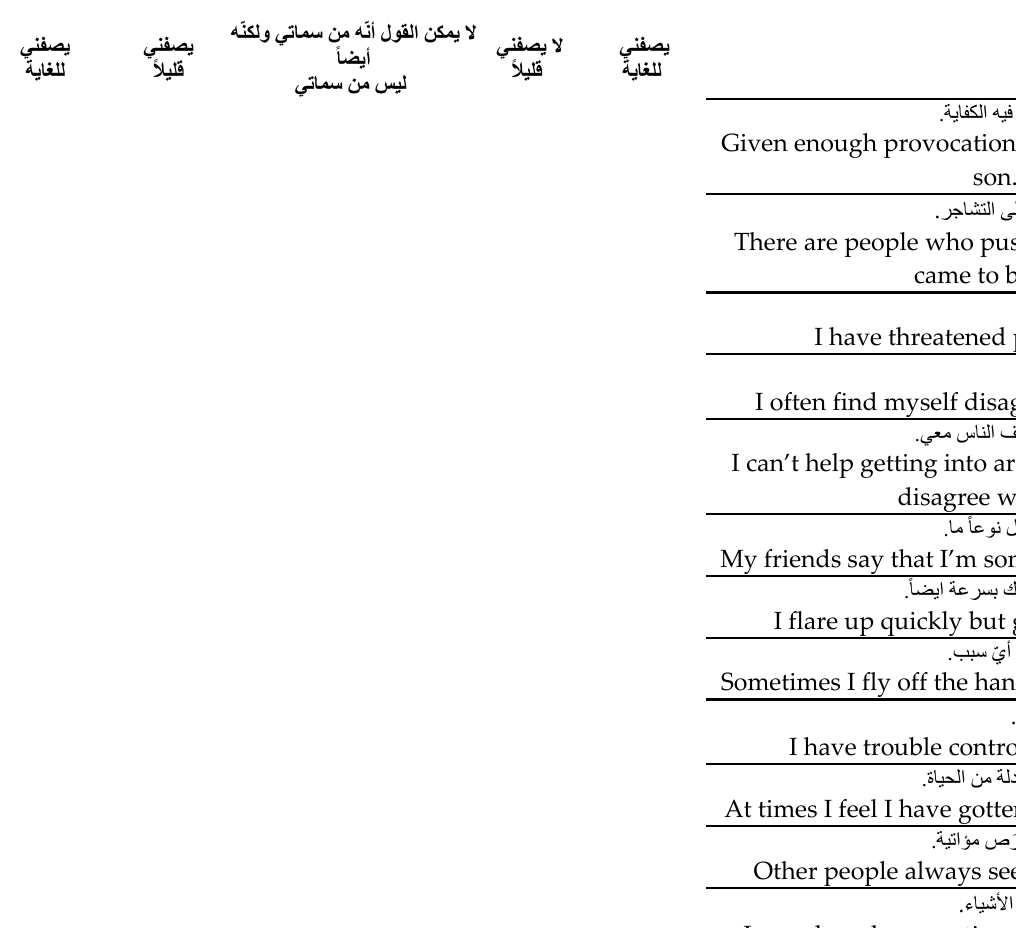
Table A1. Translated items of the Buss-Perry Aggression Questionnaire- Short Form in Arabic language.